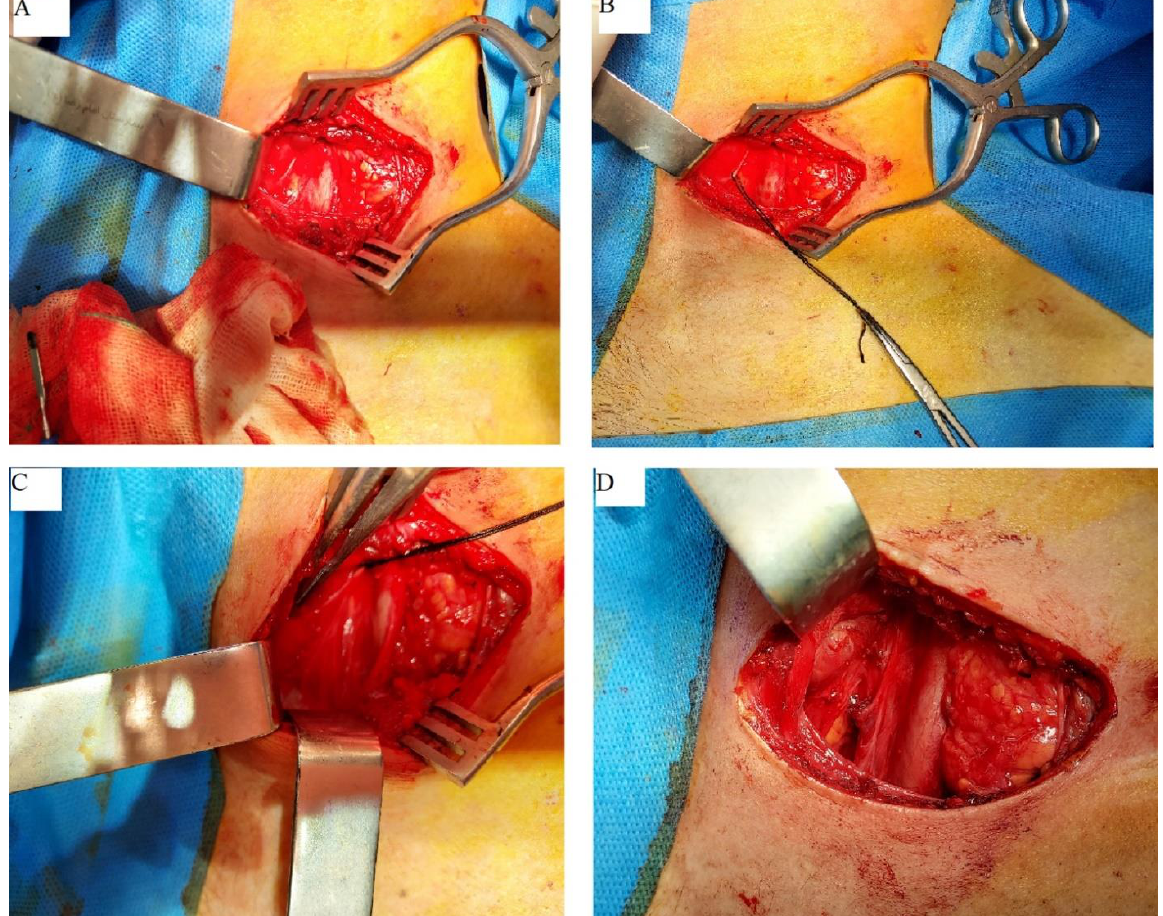
Figure 2: Left subclavian artery compressed by left anterior scalene muscle during surgery , A: left phrenic nerve dissected and preserved; B: Resection of left anterior scalene muscle; C: Left anterior scalene muscle resected; D: Release of left subclavian